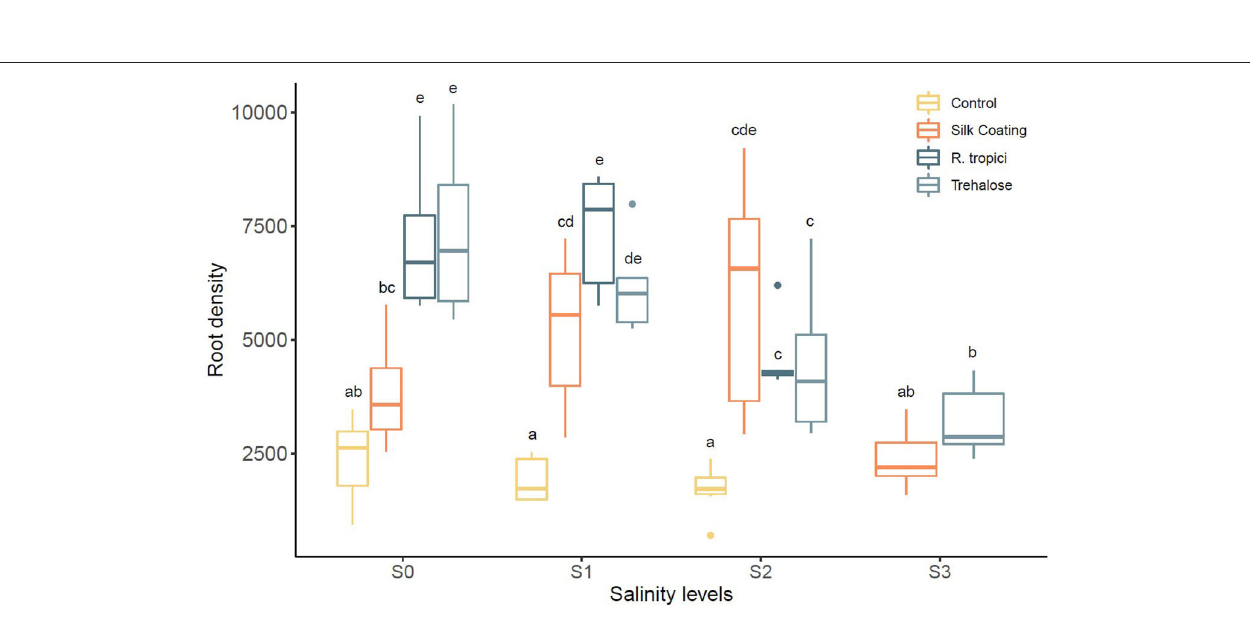
FIGURE 4 | Effect of different salinity levels ( S0 = 0mM, S1 = 25mM, S2 = 50mM, and S3 = 75mM) on Phaseolus vulgaris root